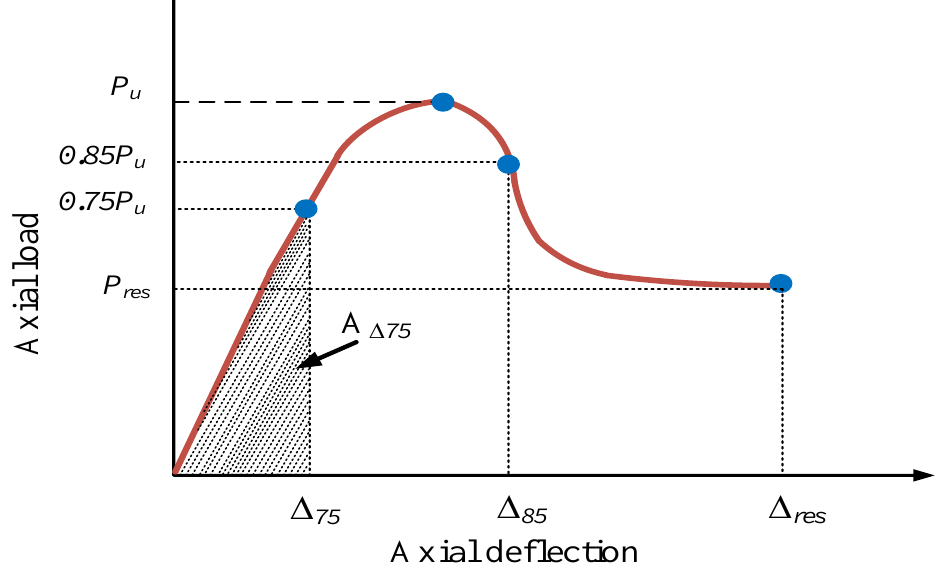
Figure 17. Ductility